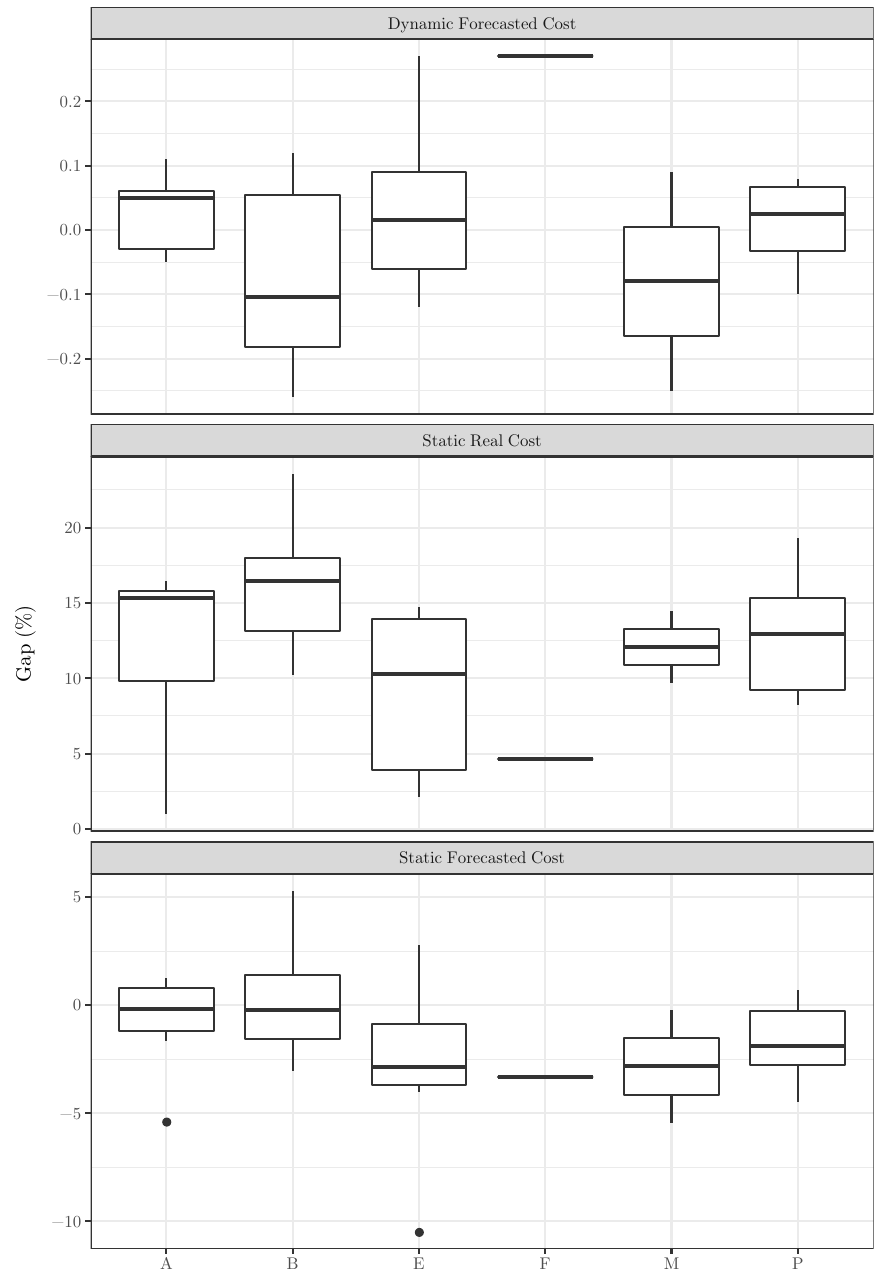
Figure 2. Multiple boxplots comparing the gaps of the different costs relative to the DRC by instance set with a uniformly distributed error term (cid:101) ∈ [ − 10 − 3 ,10 − 3 ]